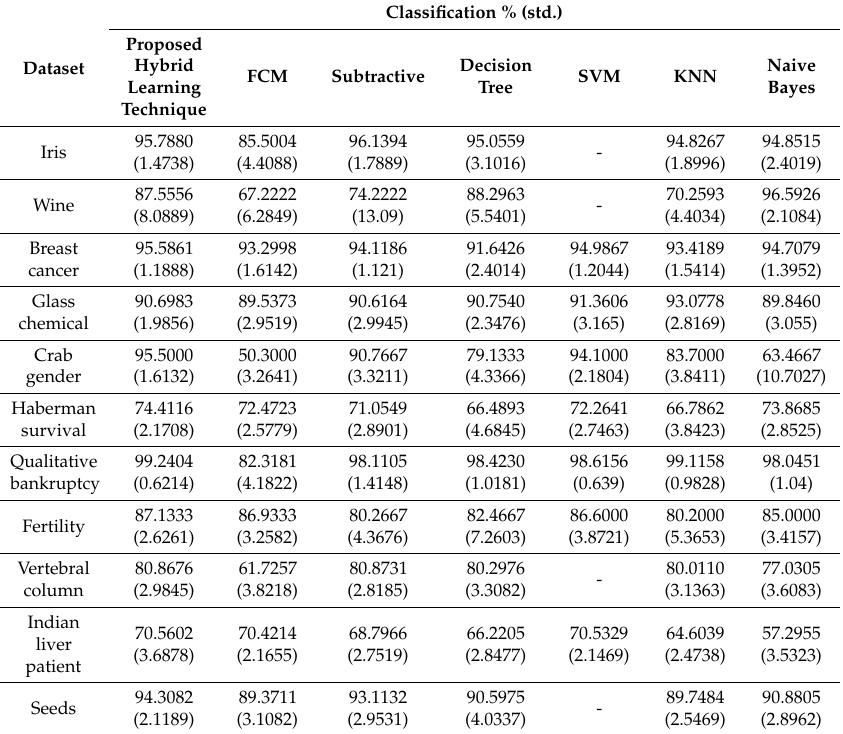
Table 2. Results for classification benchmarks.